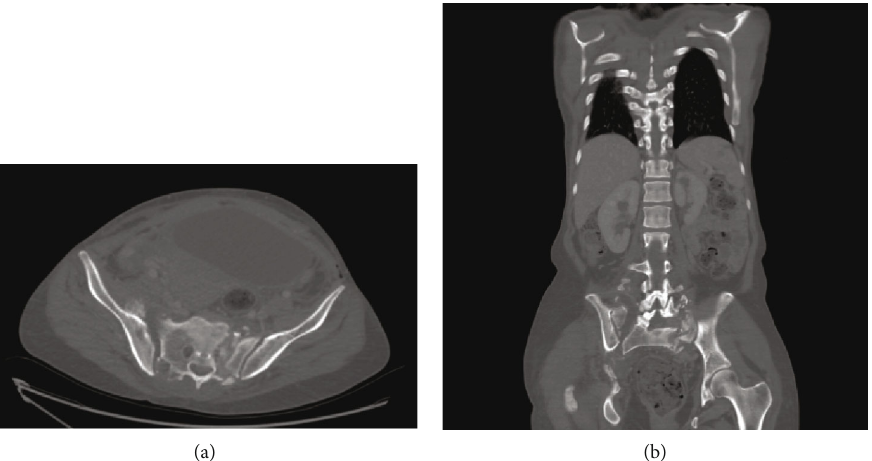
Figure 2: (a, b) CT scan of the pelvis and spine in axial (a) and coronal (b) cuts, respectively, showing spinopelvic dissociation with severe osseous destruction extending from the ala into S1 and S2.